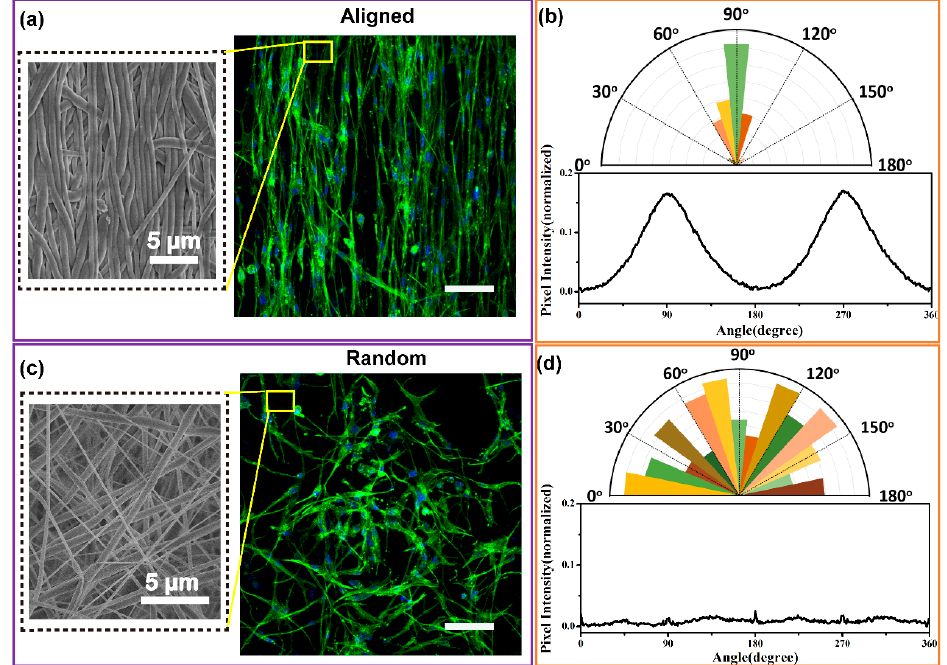
Figure 7. Attachment and alignment of MC3T3-E1 cells on well-aligned and random P(VDF-TrFE) nanofibers after 3 days of culture. ( a ) The SEM image of well-aligned nanofiber substrate (left column) and the confocal fluorescence micrographs of MC3T3-E1 cells (right column). ( b ) 2-D FFT image analysis of cell nuclei (above) and cytoskeleton alignment (below) on well-aligned P(VDF-TrFE) nanofibers. ( c ) SEM image of random nanofiber substrate (left column) and the confocal fluorescence micrographs of MC3T3-E1 cells (right column). ( d ) 2-D FFT image analysis of nuclei (above) and cytoskeleton alignment (below) on random P(VDF-TrFE) nanofibers. F-actin was stained by Alexa Fluor 488-labeled phalloidin (green); cell nuclei were stained by DAPI (blue). The scale bar for confocal fluorescence micrographs is 100 µm.